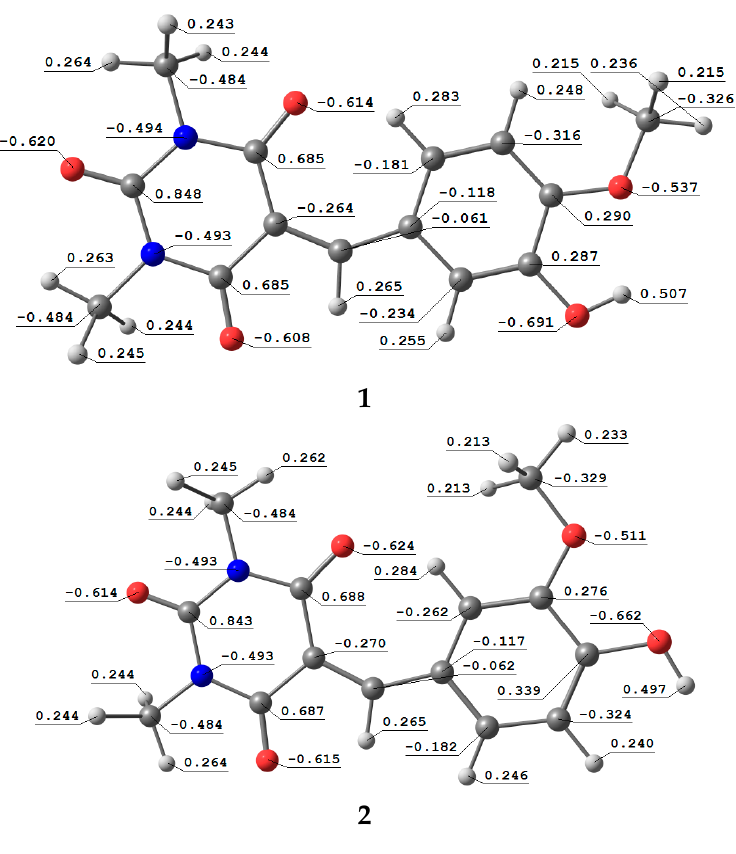
Figure 5. The natural charges at the different atomic sites of compounds 1 and 2 .